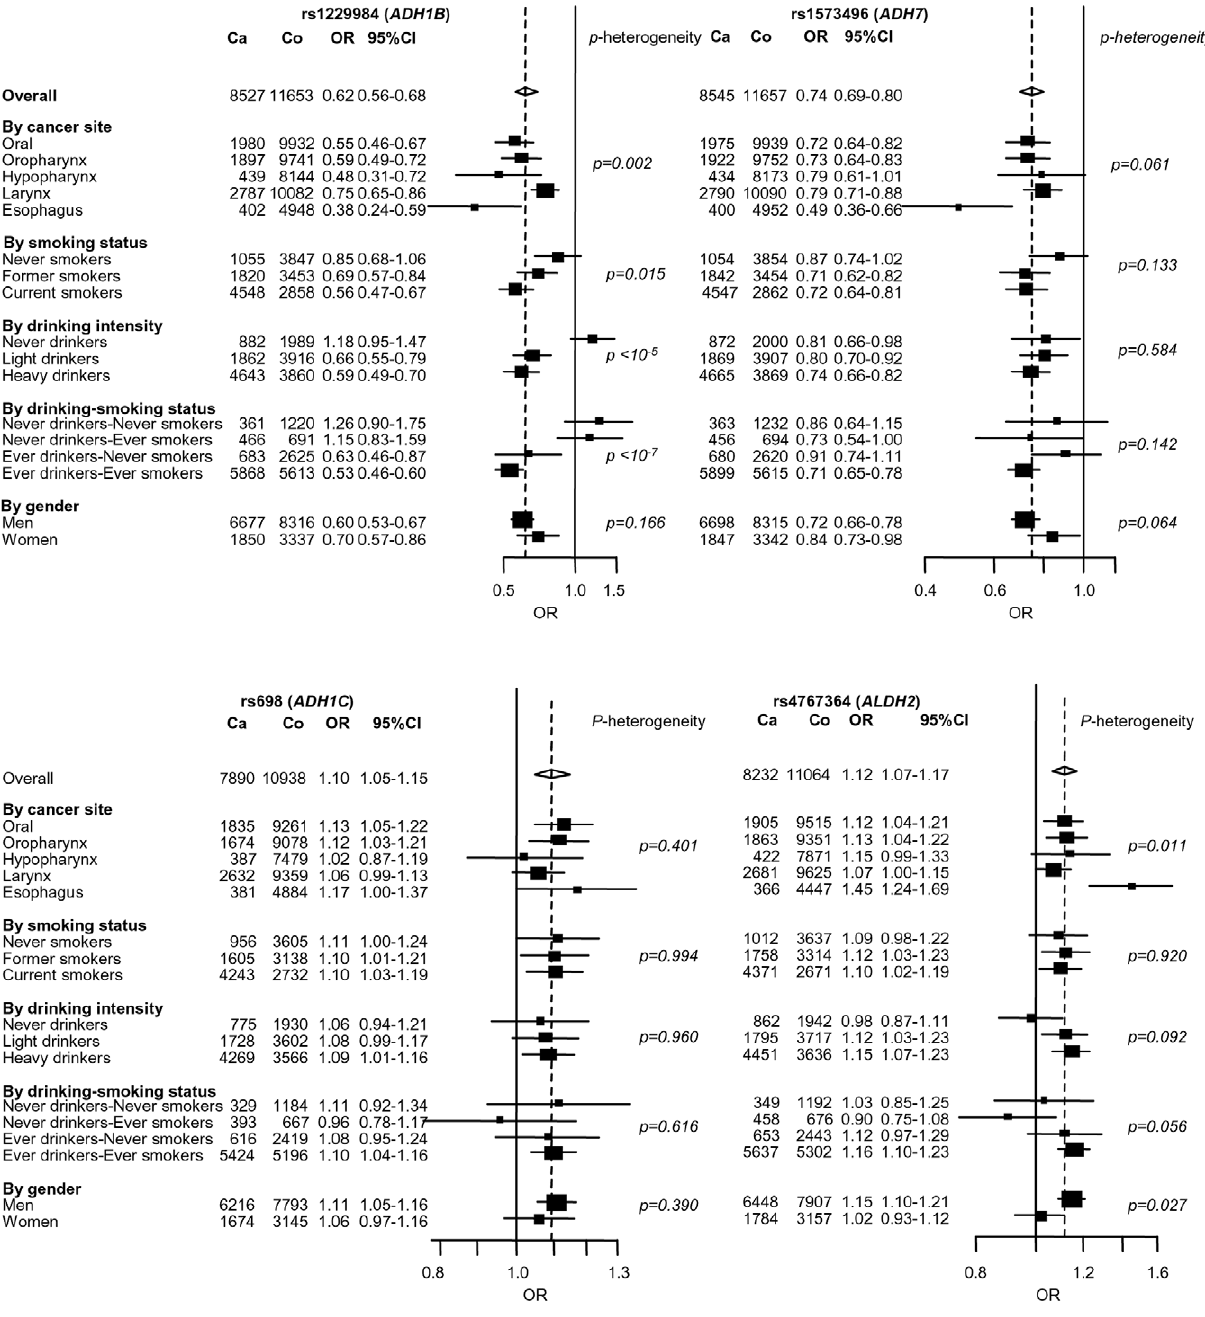
Figure 3. Stratified analysis of 4 replicated SNPs located near alcohol metabolism genes. Estimates for rs1229984 ( ADH1B ), rs1573496 ( ADH7 ), rs1042758 ( ADH1C ) and rs4767364 ( ALDH2 ) were derived from a log-additive genetic model. ORs were adjusted by age, sex, study and were derived from fixed effects models. ‘‘Generic’’ controls were not included in this analysis.